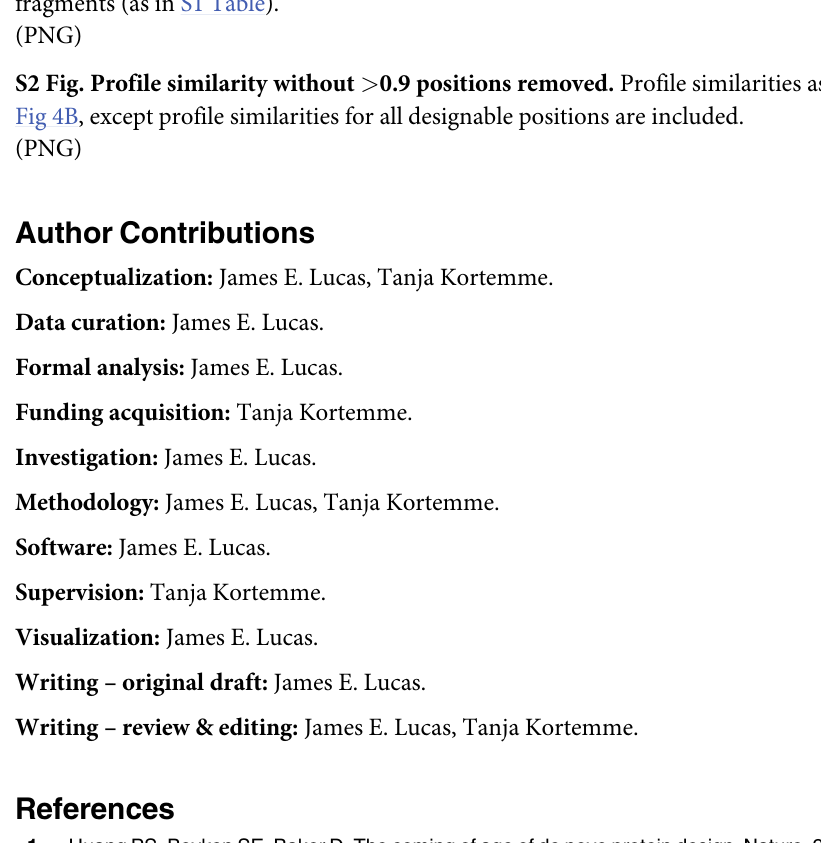
S6 Table. Counts for improved metrics across all attempted designs. Counts out of 14 compos- ite binding site matches where median metrics across 5000 designs that utilized composite Rota- merSets with special_rot bonus values were improved as compared to designs generated with unmodified Packer. PackStat and shape complementarity are considered improved if the median increased relative to the unmodified Packer. Ligand SASA, binding strain (bindingstrain), residue interaction energy (residueie), and RosettaHoles are considered improved if the median decreased relative to the unmodified packer. Number of hydrogen bonds made with the ligand (hbonds) is considered improved if the median count is more than the median count for the unmodified Packer. Heavy buried unsatisfied hydrogen bond donor/acceptor count (heavyburiedunsats) is considered improved if the median count is less than the median count for the unmodified Packer. S7 Table. Feature vector components. Descriptions of individual feature vector components used to cluster residue-fragment interactions into unique contact modes using hierarchical agglomerative clustering. S1 Fig. Fraction of PDB required for > 80% contact recovery across all tested fragments. Counts for the fraction of the PDB required to achieve > 80% contact recovery for all 34 tested fragments (as in S1 Table). S2 Fig. Profile similarity without > 0.9 positions removed. Profile similarities as depicted in Fig 4B, except profile similarities for all designable positions are